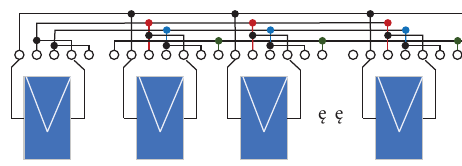
Figure 1: Structure of the switching